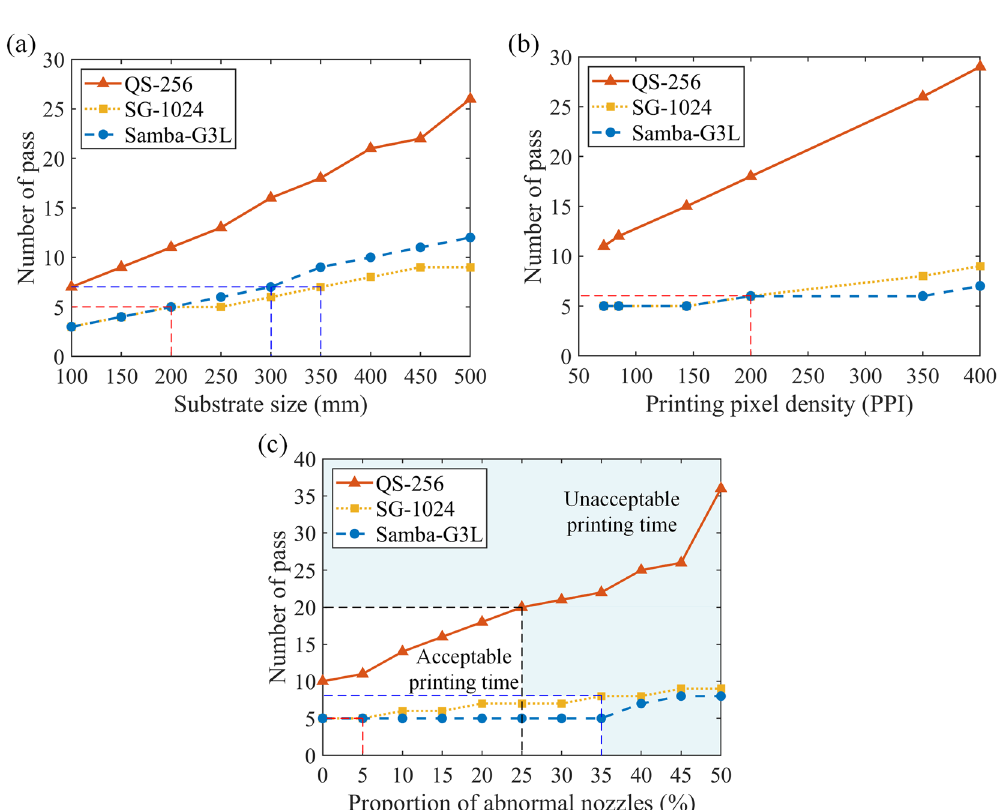
Figure 7. Simulation results of different parameters on the number of printing passes. ( a ) Effect of the substrate size (in the case of 72 PPI substrate). ( b ) Effect of the printing pixel density. ( c ) Effect of the abnormal nozzle proportion on the printhead (in the case of 72 PPI